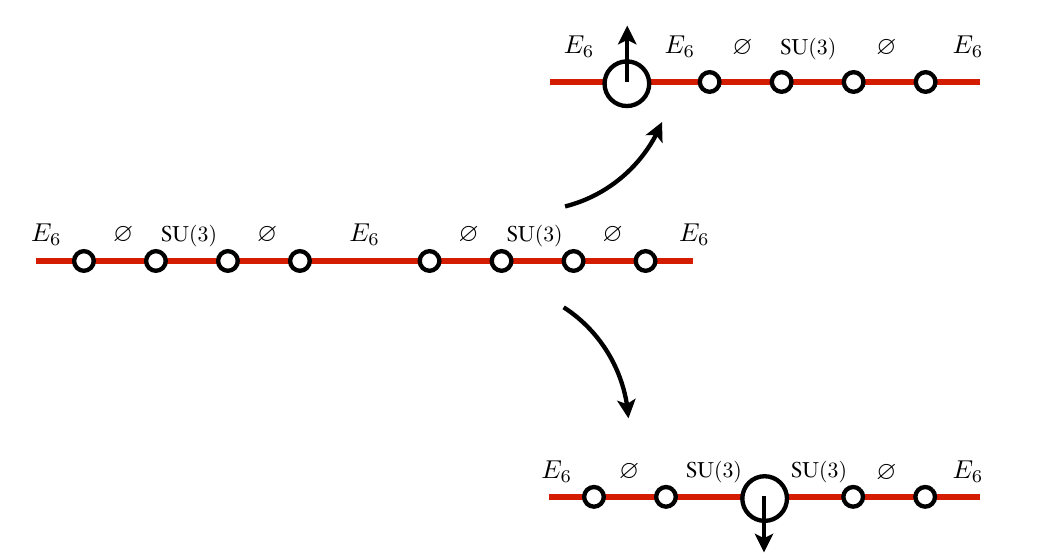
Figure 1 . The central part of the picture represents fractional 2 M5-branes (dots) on a R (cid:2) R 4 = (cid:0) E singularity (red line). In this case each of the individual fractions is 1 = 4 an ordinary M5. (To be precise, the M5 charges of the fractions are not the same. The fraction between E 6 and ? has charge 1 = 3, while the one between ? and SU(3) has charge 1 = 6; see (2.9).) We also show the gauge groups (or lack thereof) on each segment between two fractional M5s. On the top part of the picture, we show a situation where the (cid:12)rst four fractions have recombined into a full M5; the latter can now be pulled o(cid:11) the singularity. On the bottom part of the picture we see a di(cid:11)erent transition, where the fractions have come together in a di(cid:11)erent